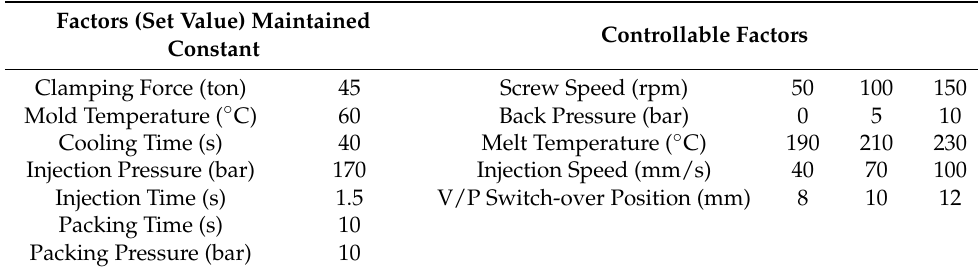
Table 1. Configuration of the molding parameters for the molding of PP and PS samples.